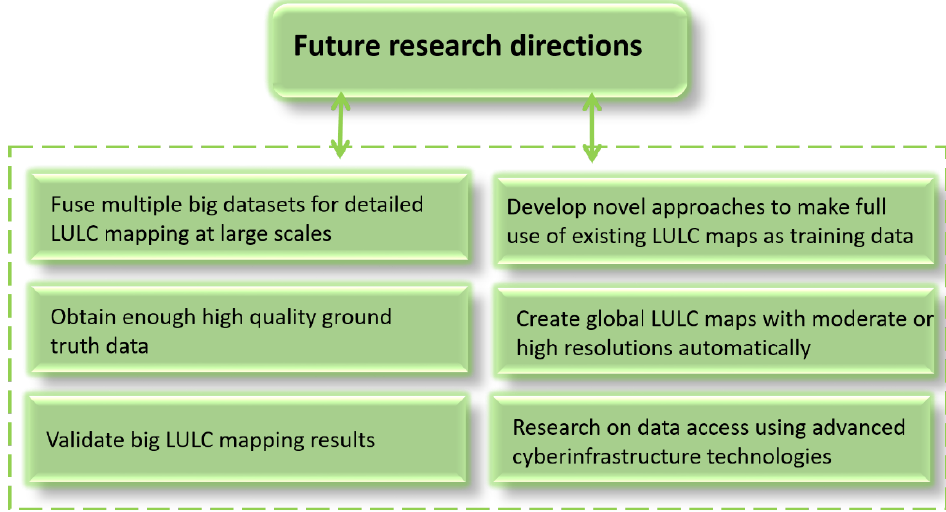
Figure 10. Future research directions of LULC mapping.